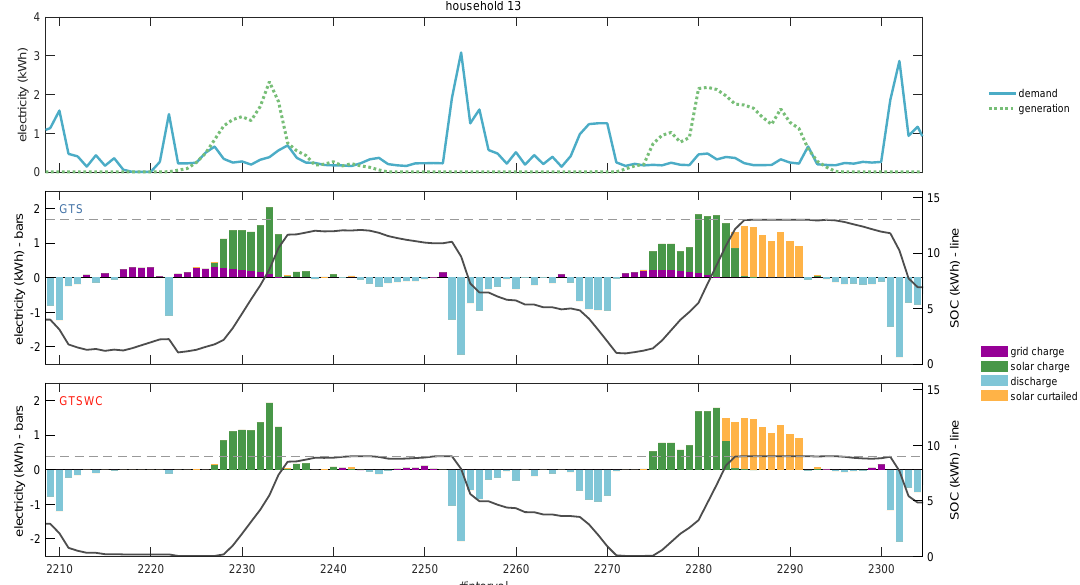
Figure 8. Demand, generation and battery usage. The demand and generation profiles of Household 13 for two representative days are shown. Furthermore, the specific battery usage based on the GTS and GTSWC approaches is presented. For the lower two plots, the left-hand axes represent the electricity values for the bars, while the right-hand axes indicate the SOC of the respective